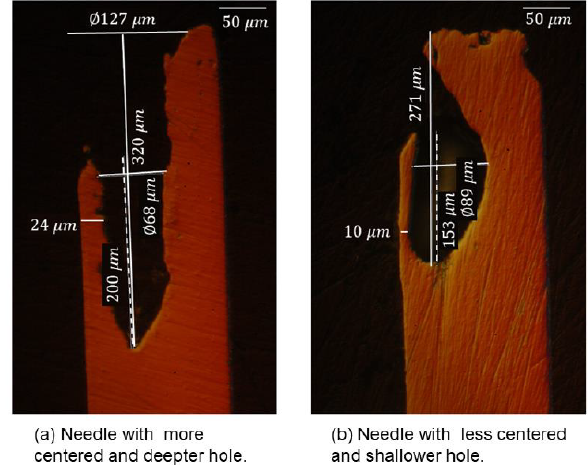
Figure 11: Microholes on stainless steel plates drilled by 7, 13, 18, and 24 repetitions of the three 10 µ s pulse group.